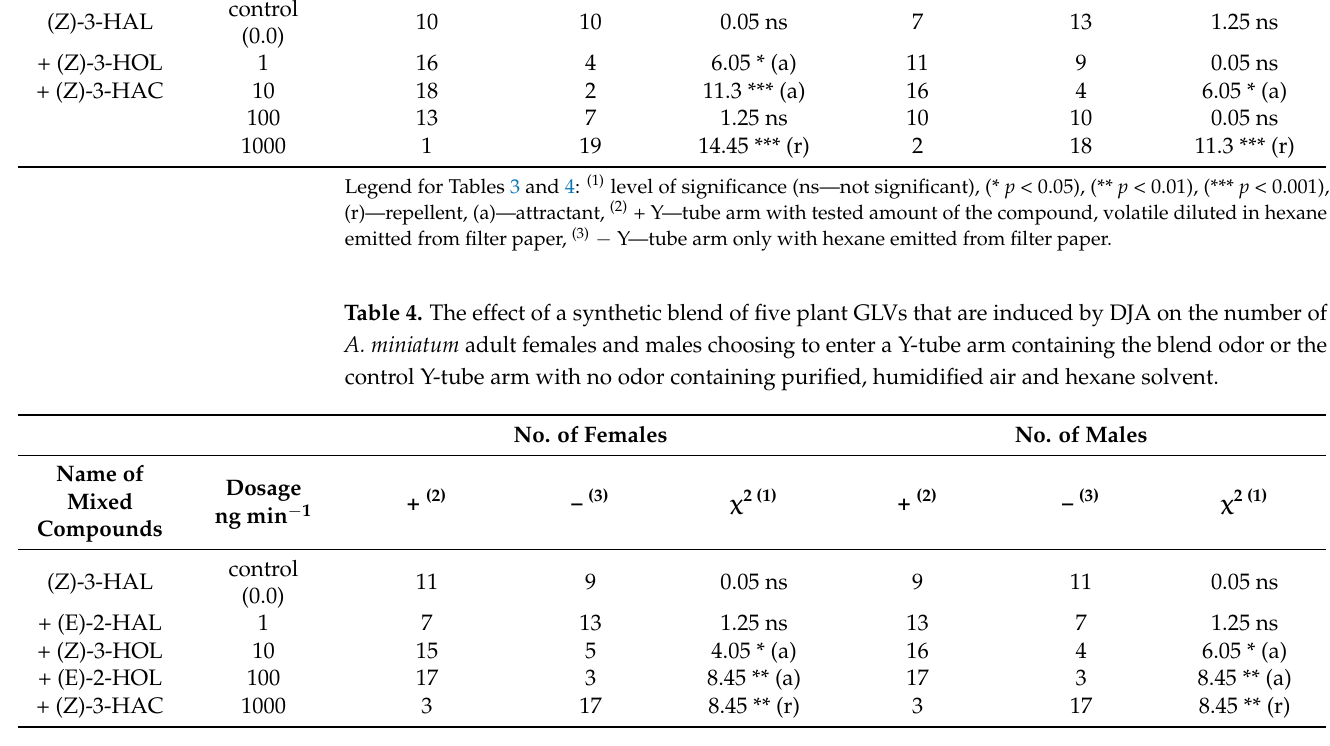
Table 3. The effect of a synthetic blend of three plant GLVs that are induced by ZJA on the number of A. miniatum adult females and males choosing to enter a Y-tube arm containing the blend odor or the control Y-tube arm with no odor, containing purified, humidified air and hexane solvent. No. of Females No. of Males